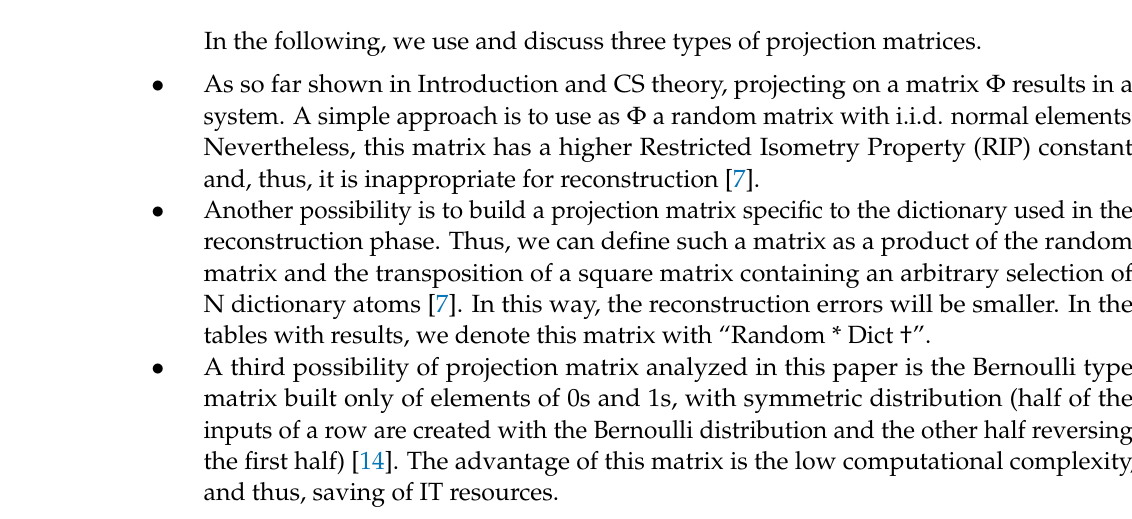
Figure 1. Examples of cardiac patterns obtained by centered or non-centered R-wave: ( a ) Cardiac patterns with a centered R-wave; ( b ) Cardiac patterns without a centered R-wave.